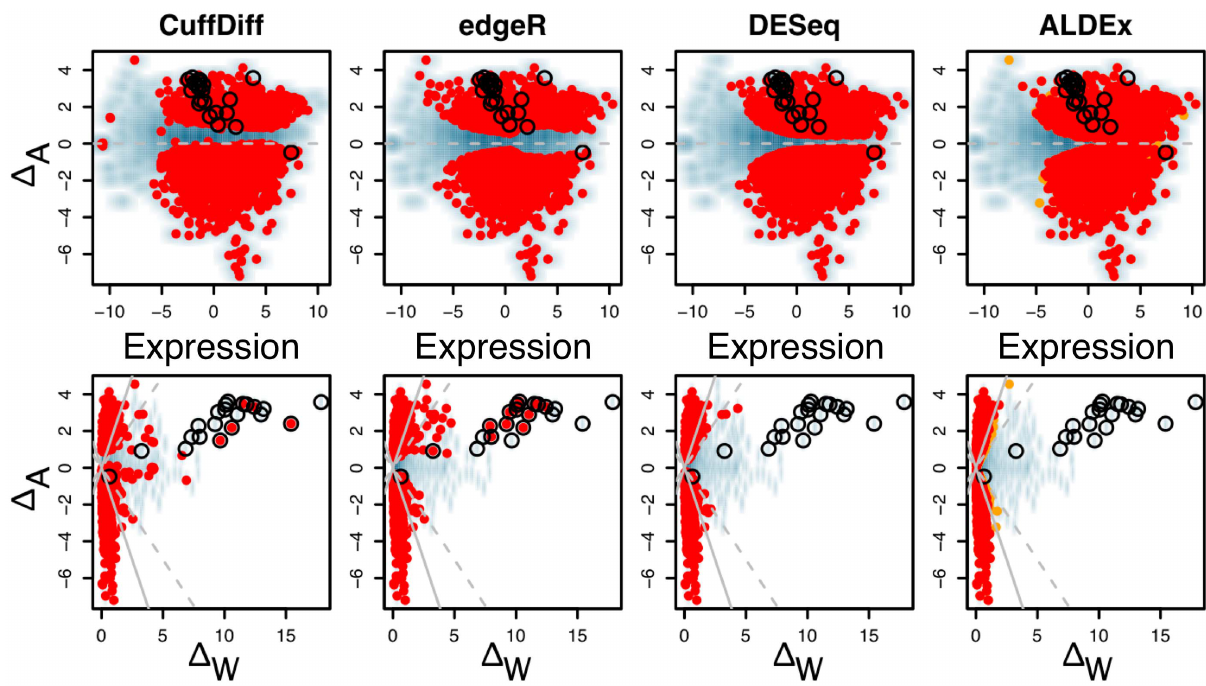
Figure 5. Comparison of four differential expression methods in the B.cereus dataset. Transcript abundances identified as differential by the first three methods are highlighted in red on a background density plot. Default false discovery rates for each program were used, 0.05 for CuffDiff and 0.1 for both edgeR and DESeq, since these reflect the configurations in which most users will use these programs. In the case of ALDEx ƒ 0 : 01 are highlighted in red and orange for j D § 2 and j D § 1 : 5 . Transcripts originating from genes contained on the plasmid transcripts with D Q 0 R j R j A that is found in one sample from each condition are circled. The top row shows typical Bland-Altman style (MA) plots where the median absolute fold change ( D A ) is plotted vs. the mean expression value (Expression). The mean expression value on x-axis is 0 for the reasons outlined in the text. Notice that the edgeR method identifies differentially-expressed transcripts with much lower abundances than the other three methods. The plasmid- encoded genes are not differentiated on the Bland-Altman-style plots. The bottom row shows an MW plot of the median absolute fold change between-conditions ( D A ) vs. the maximum within-condition difference ( D W ) of the same data. Here it is clear that transcripts originating from the plasmid-encoded genes exhibit very large D W values. Interestingly, there are a number of chromosomally-encoded genes in this dataset, and in the other two (see previous figure) that also show large D W values, demonstrating that within-condition variation can be problematic even for samples derived from well-controlled conditions. Both CuffDiff and edgeR identified as differentially expressed a significant fraction of the plasmid-derived transcripts.